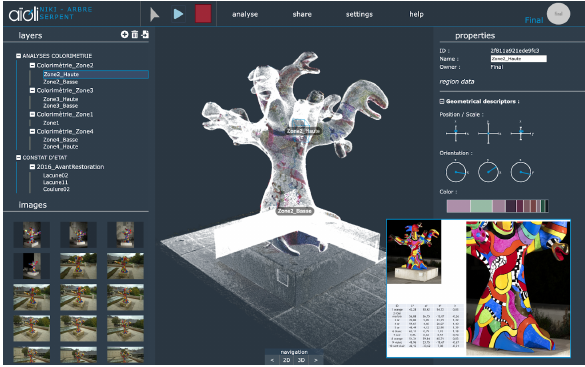
Figure 9 . Registration of UV fluorescence to reveal and propagate past-restoration annotations on « Expansion Contrôlée